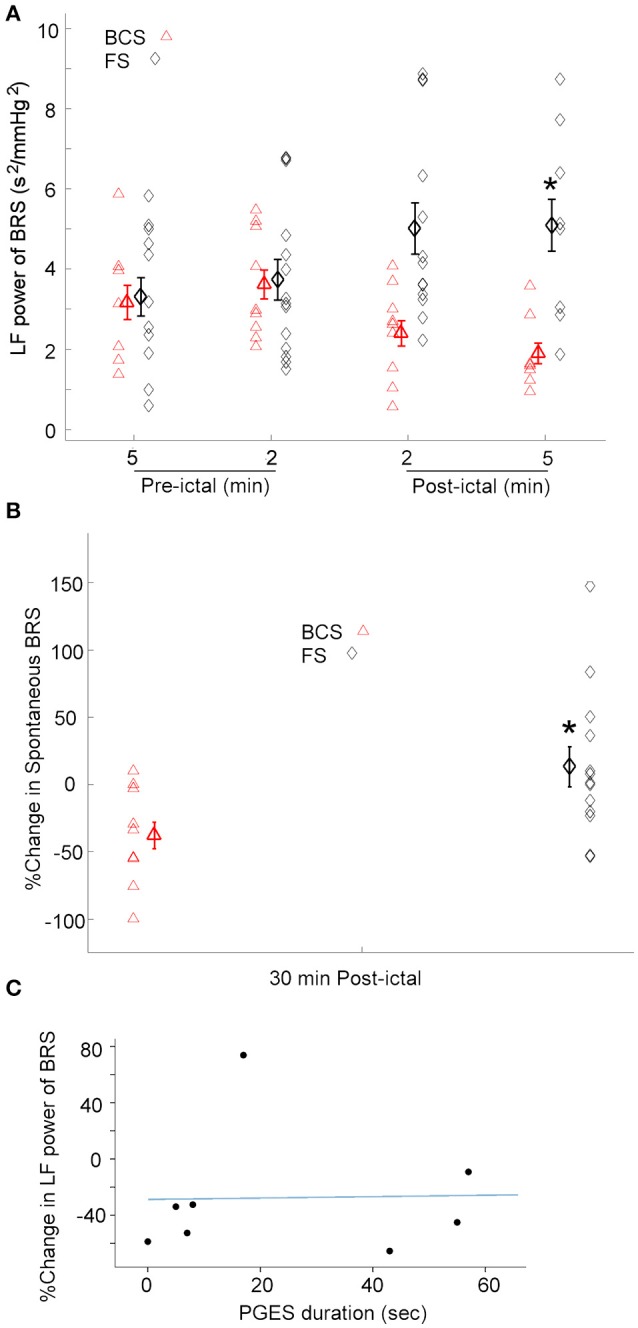
BRS following BCS, FS, and PGES. (A) LF power of the BRS decreased after BCS compared to the FS indicating compromised BRS in BCS. This suggests the transient impairment of the central autonomic control of the cardiovascular system immediately after BCS. (*p < 0.05 compared to the BCS, Two-way ANOVA; Tukey's post-hoc test). (B) Similarly, spontaneous BRS decreased after BCS compared to the FS during 30 min post-ictal (*p < 0.05 compared to the BCS). (C) Scatter plot shows no significant correlation between post-ictal percent change of baroreflex sensitivity and PGES duration.